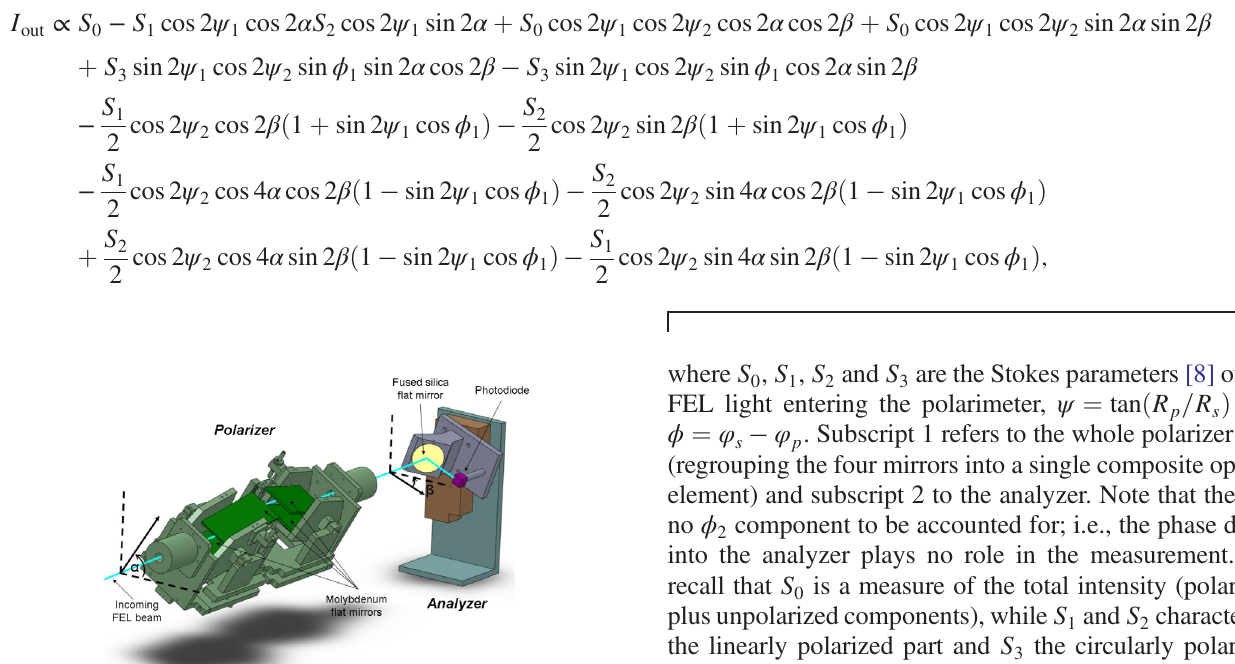
Figure 5 is a sketch of the whole system. The polarizer